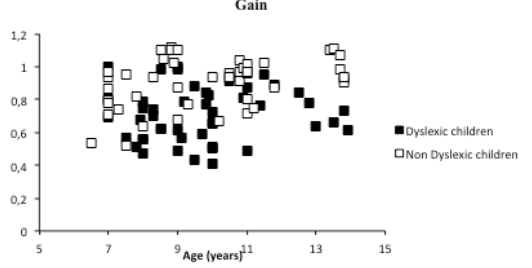
Figure 4. Gain (ratio of the eye velocity over the target ve- locity) for dyslexic and non-dyslexic children